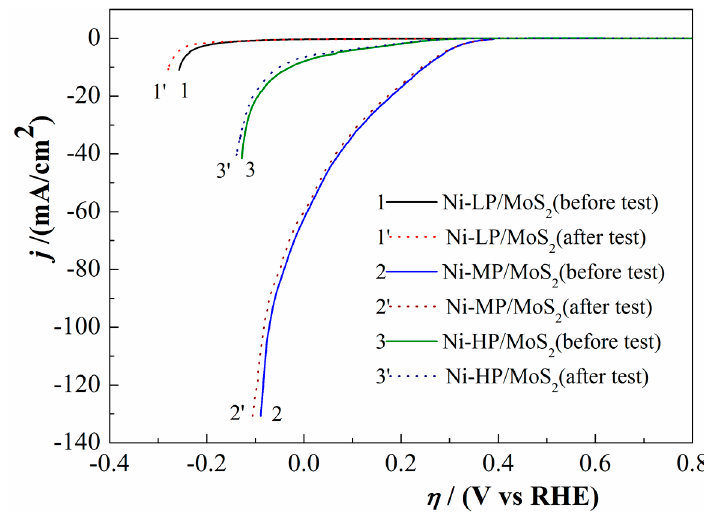
Figure 8. Stability tests for Ni–LP/MoS 2 , Ni–MP/MoS 2 , and Ni–HP/MoS 2 composites. Scan rate: 50 mV/s; potential window: − 0.3 and 0.8 V (vs. RHE).